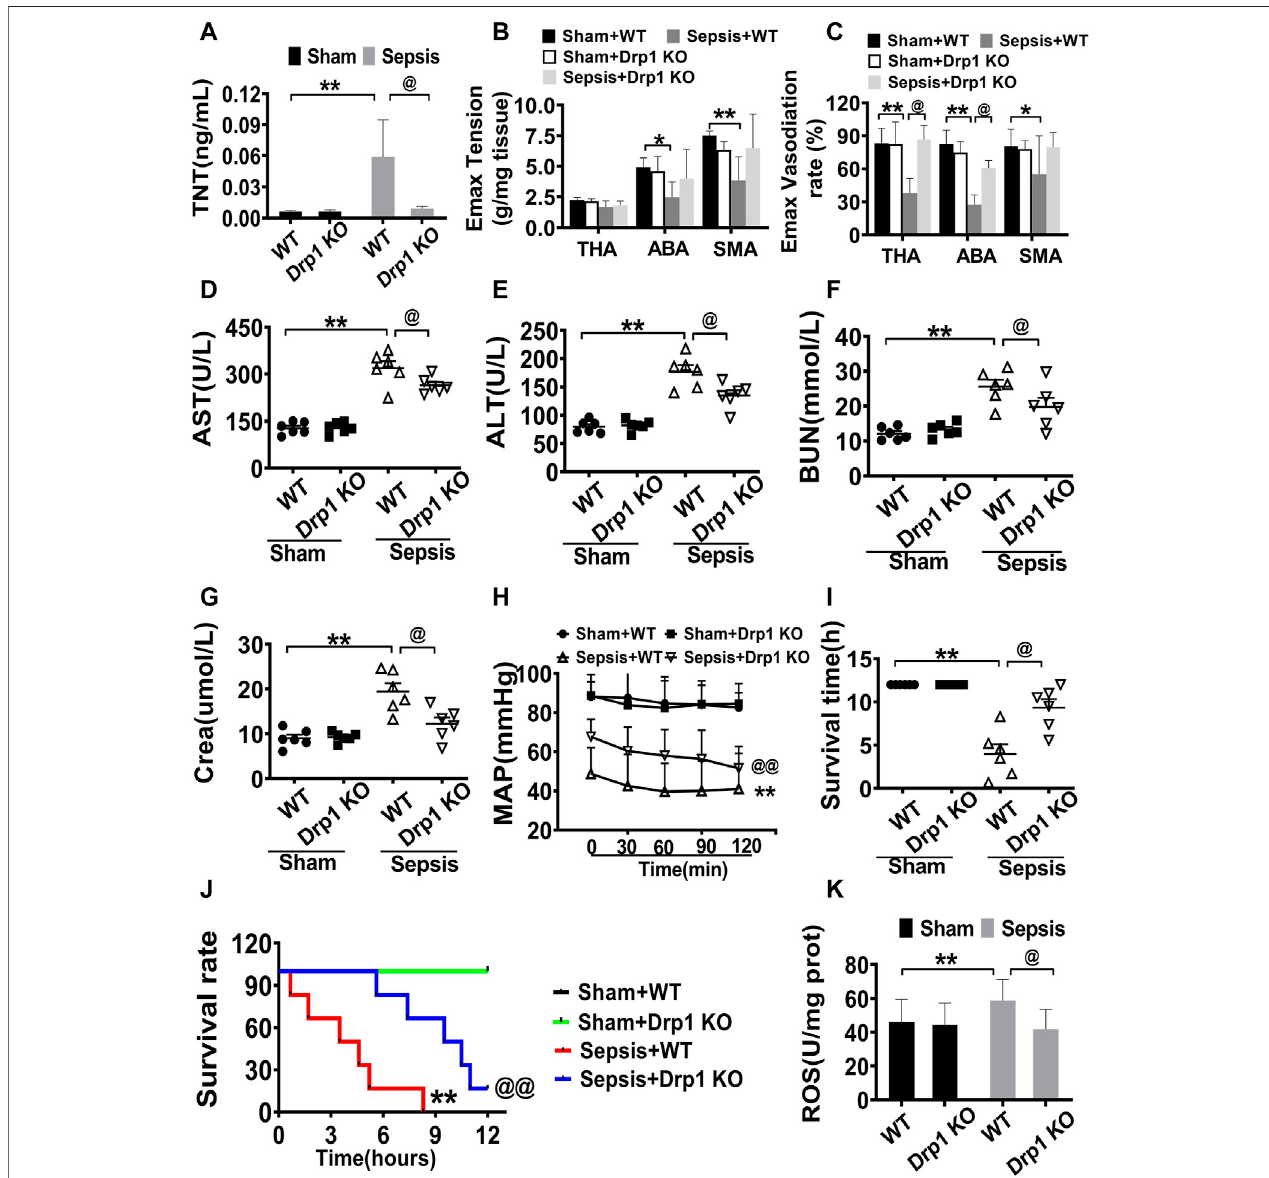
FIGURE 6 | Protective effects of Drp1 knockout in septic mice. (A) : troponin T, a marker of heart damage. (B,C) : Effects of Mdivi-1 on vascular contractile and relaxation function in Drp1 KO mice. (D) : AST (aspartate aminotransferase). (E) : ALT (alanine transaminase). (F) : BUN (blood urea nitrogen). (G) : Crea (creatinine). (H) : MAP(meanarterialpressure). (I) :survivaltime. (J) :survivalrate. (K) :ROScontentincardiac muscle.** p < 0.01versusShamofwildtype. @ p < 0.05,@@ p < 0.01versus sepsis of wild type. WT (cid:1) wild type, Drp1 KO (cid:1) Drp1 knockout. TNT (cid:1) troponin T. ABA: abdominal aorta. THA: thoracic aorta. SMA: superior mesenteric arteria.